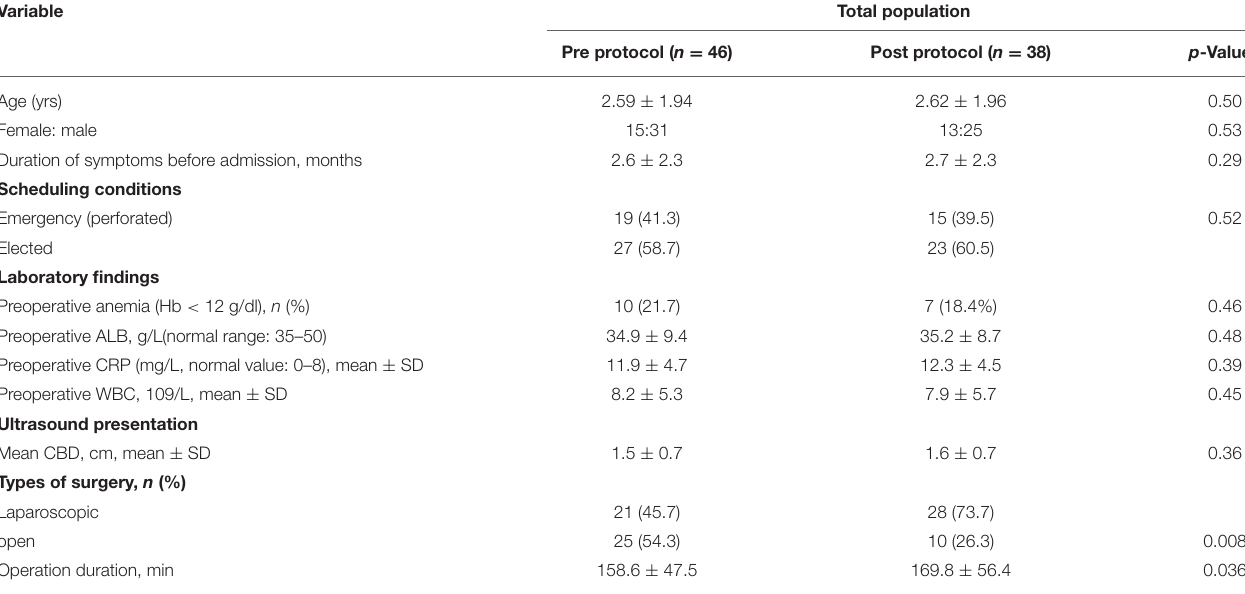
TABLE 1 | Base characteristics in children with bile leakage following Roux-en-Y hepaticojejunostomy.